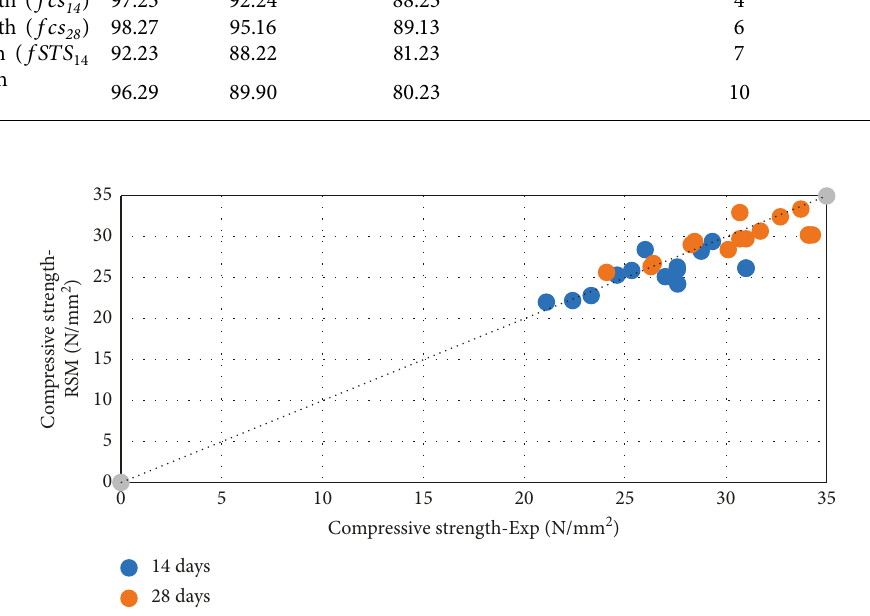
Figure 5: Predicted and actual values of compressive strength.